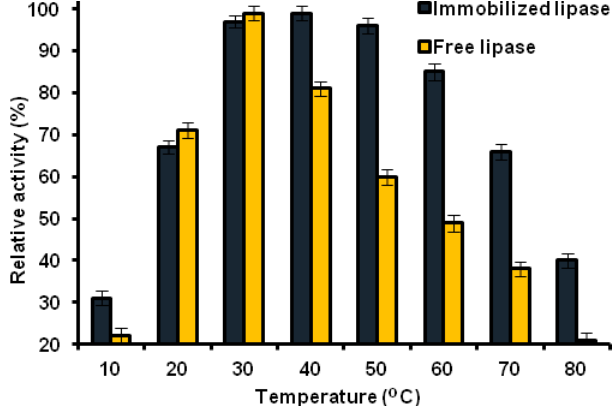
Figure 9. Thermal stability of native and immobilized lipase in the temperature range 10–80 °C.